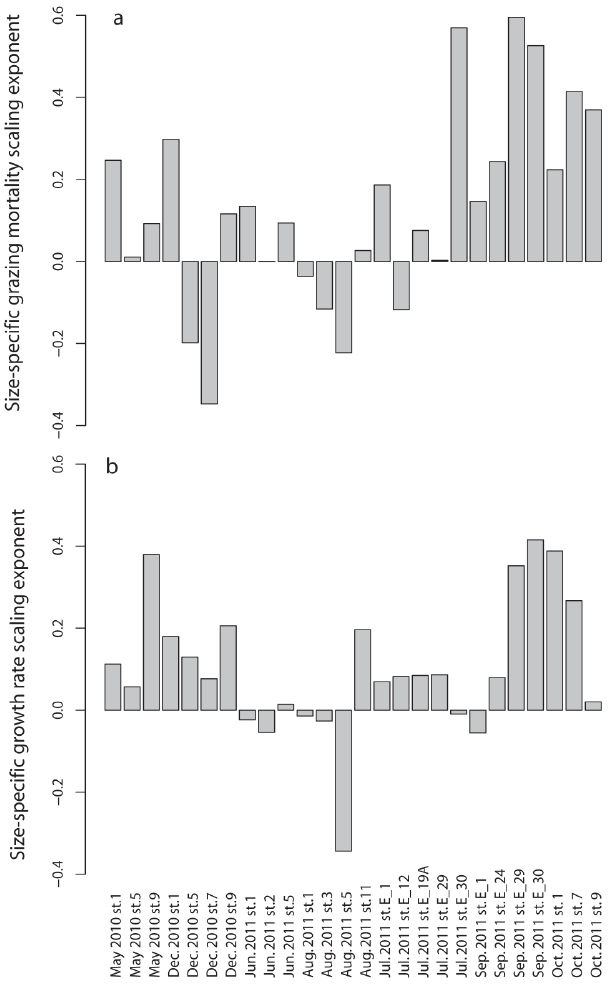
Fig. 3. Barplot showing the scaling exponent of size-specific growth rate (a) and size-specific grazing mortality scaling (b) of each sta- tion. The average of growth rate scaling is 0.103, and the average grazing mortality scaling is 0.128. The bootstrapped 95% confi- dence interval is 0.040 to 0.164 for the growth rate scaling and 0.040 to 0.219 for the grazing mortality